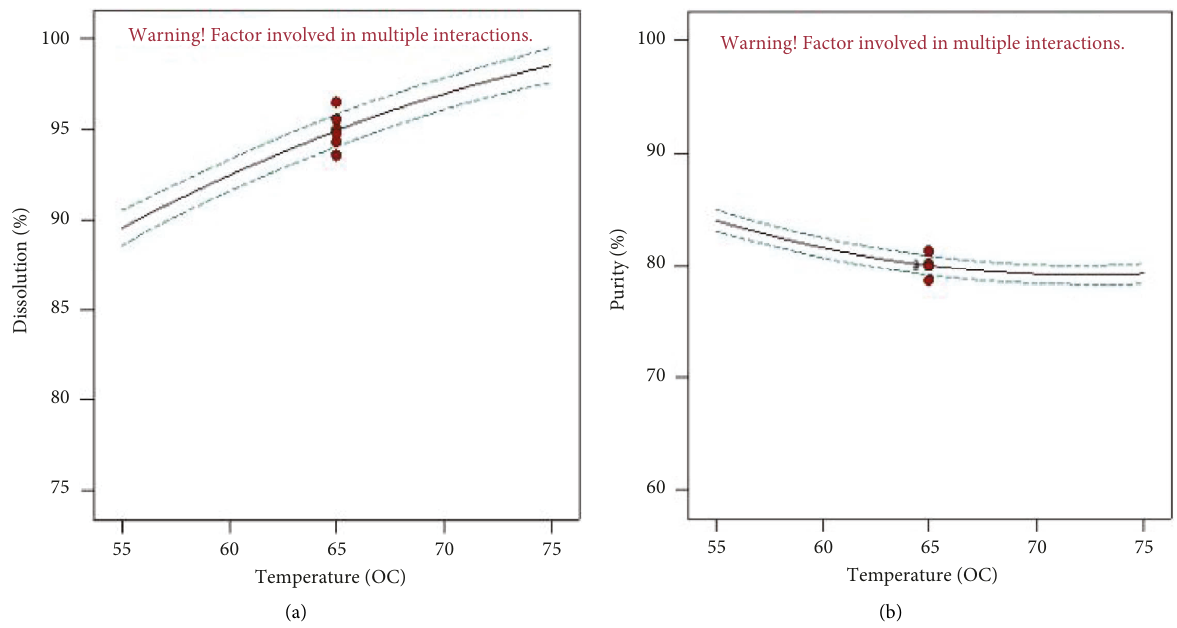
Figure 4: Effect of temperature on (a) dissolution and (b) purity of keratin.